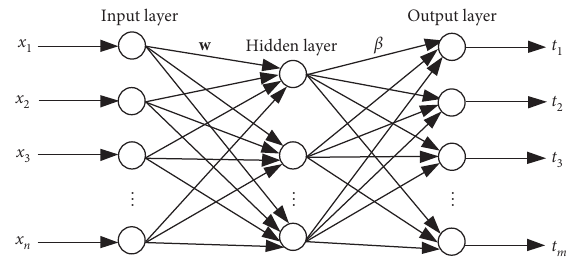
Figure 1: Extreme learning